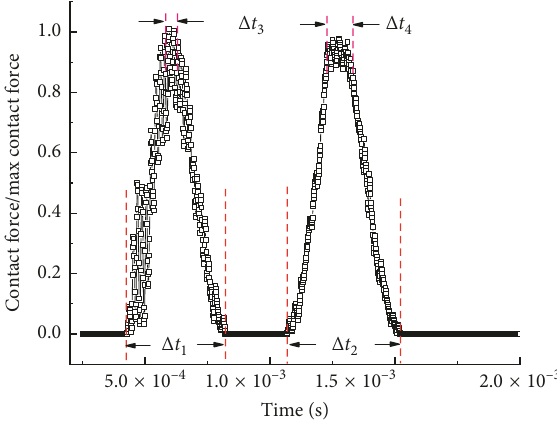
Figure 19: Time history response of the contact force on the casing.